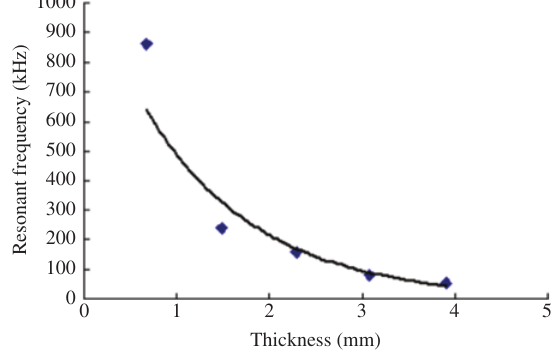
Figure 11: Relationship between thickness and resonant